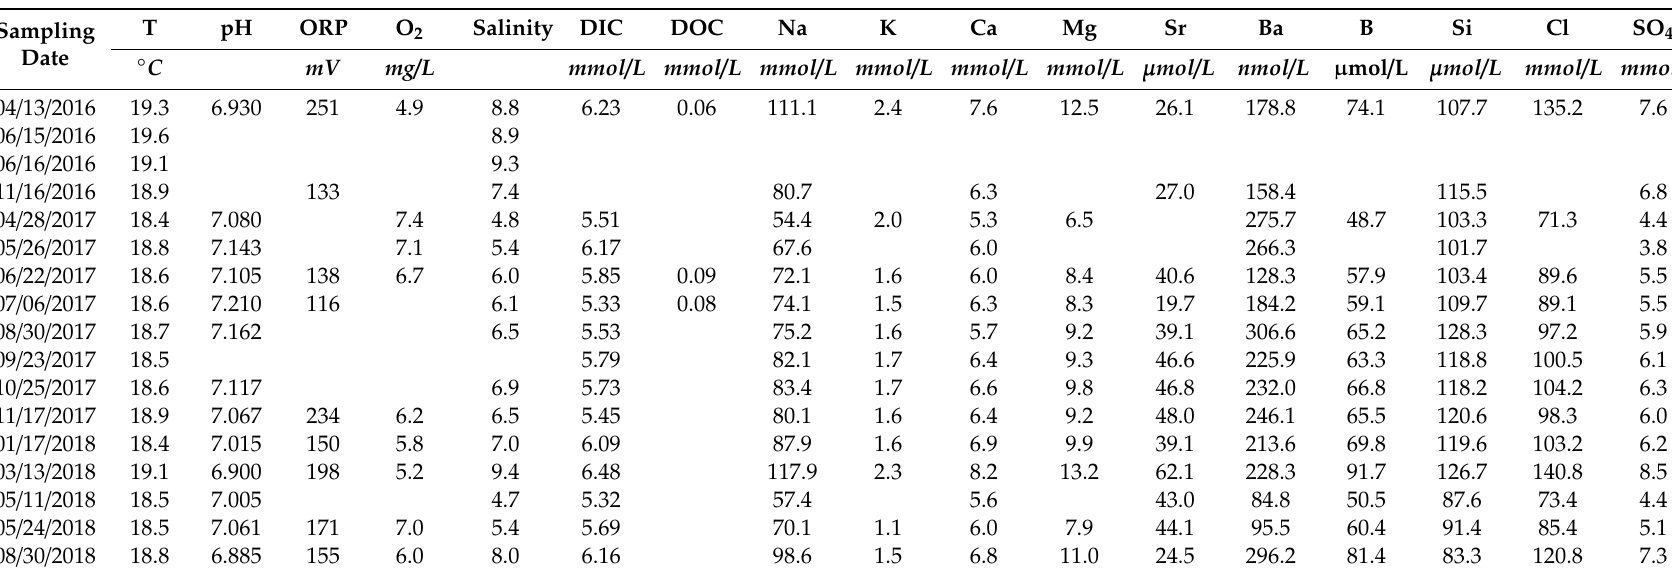
Table 1. Parameters measured in situ (T, pH, O 2 , ORP, salinity) and chemical composition of the karstic spring waters. DIC = Dissolved Inorganic Carbon. DOC = Dissolved Organic Carbon (DIC and DOC are given in moles of carbon). ORP = Oxydo-Reduction Potential (with respect to the Ag / AgCl standard).